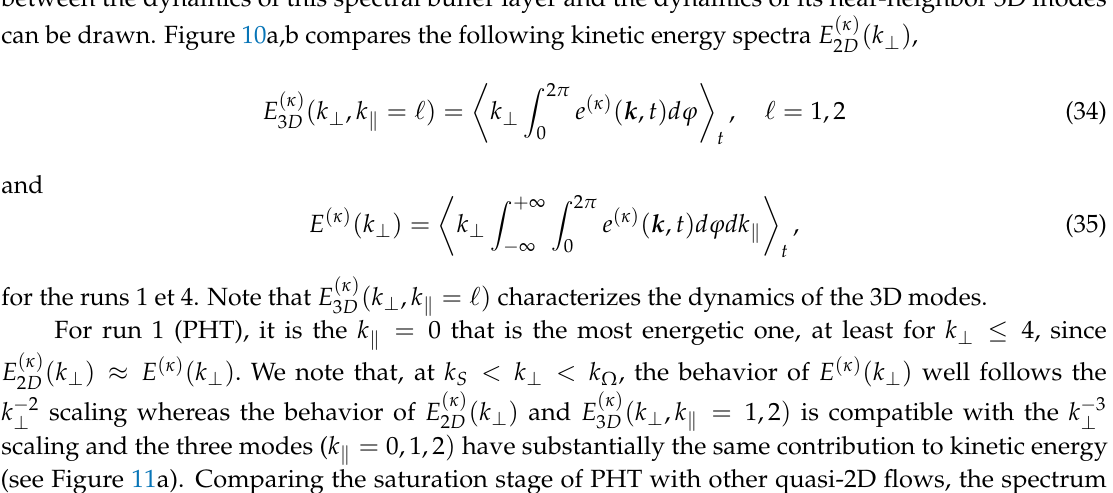
Figure 9. Kinetic energy spectra of runs 1 and 4. ( a ) displays the 2D kinetic energy E to the k (cid:107) = 0 mode. ( b ) and its inset respectively show the 2D horizontal and vertical kinetic energies. The dashed straight lines, which indicate the k − 2 ⊥ scaling, delimit the range k S = 4 ≤ k ⊥ ≤ k Ω =